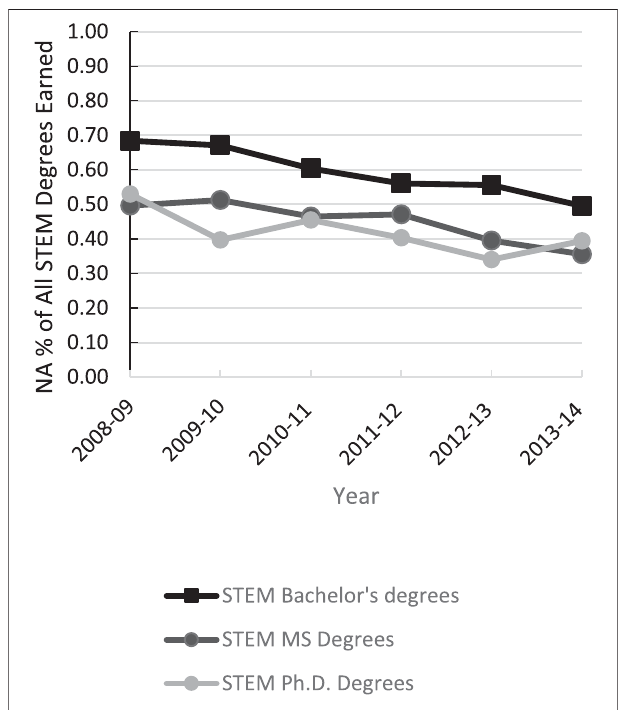
FIGURE 1 | The percent of AI/AN students in the United States earning STEM degrees compared to the total population between 2008 and 2014 (National Center for Education Statistics,